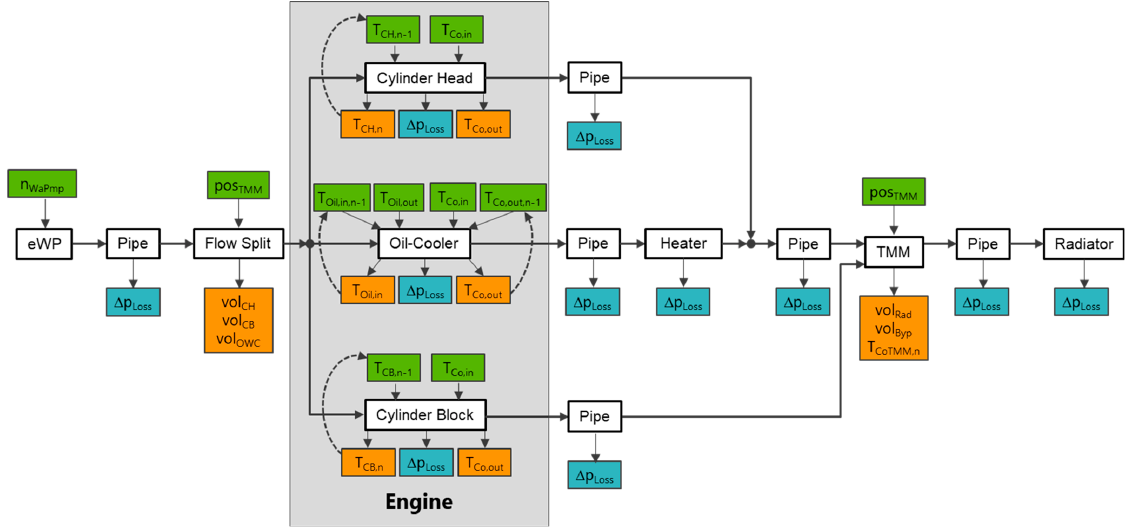
Figure 7. Process for the simulation actual temperatures and flow rates on the